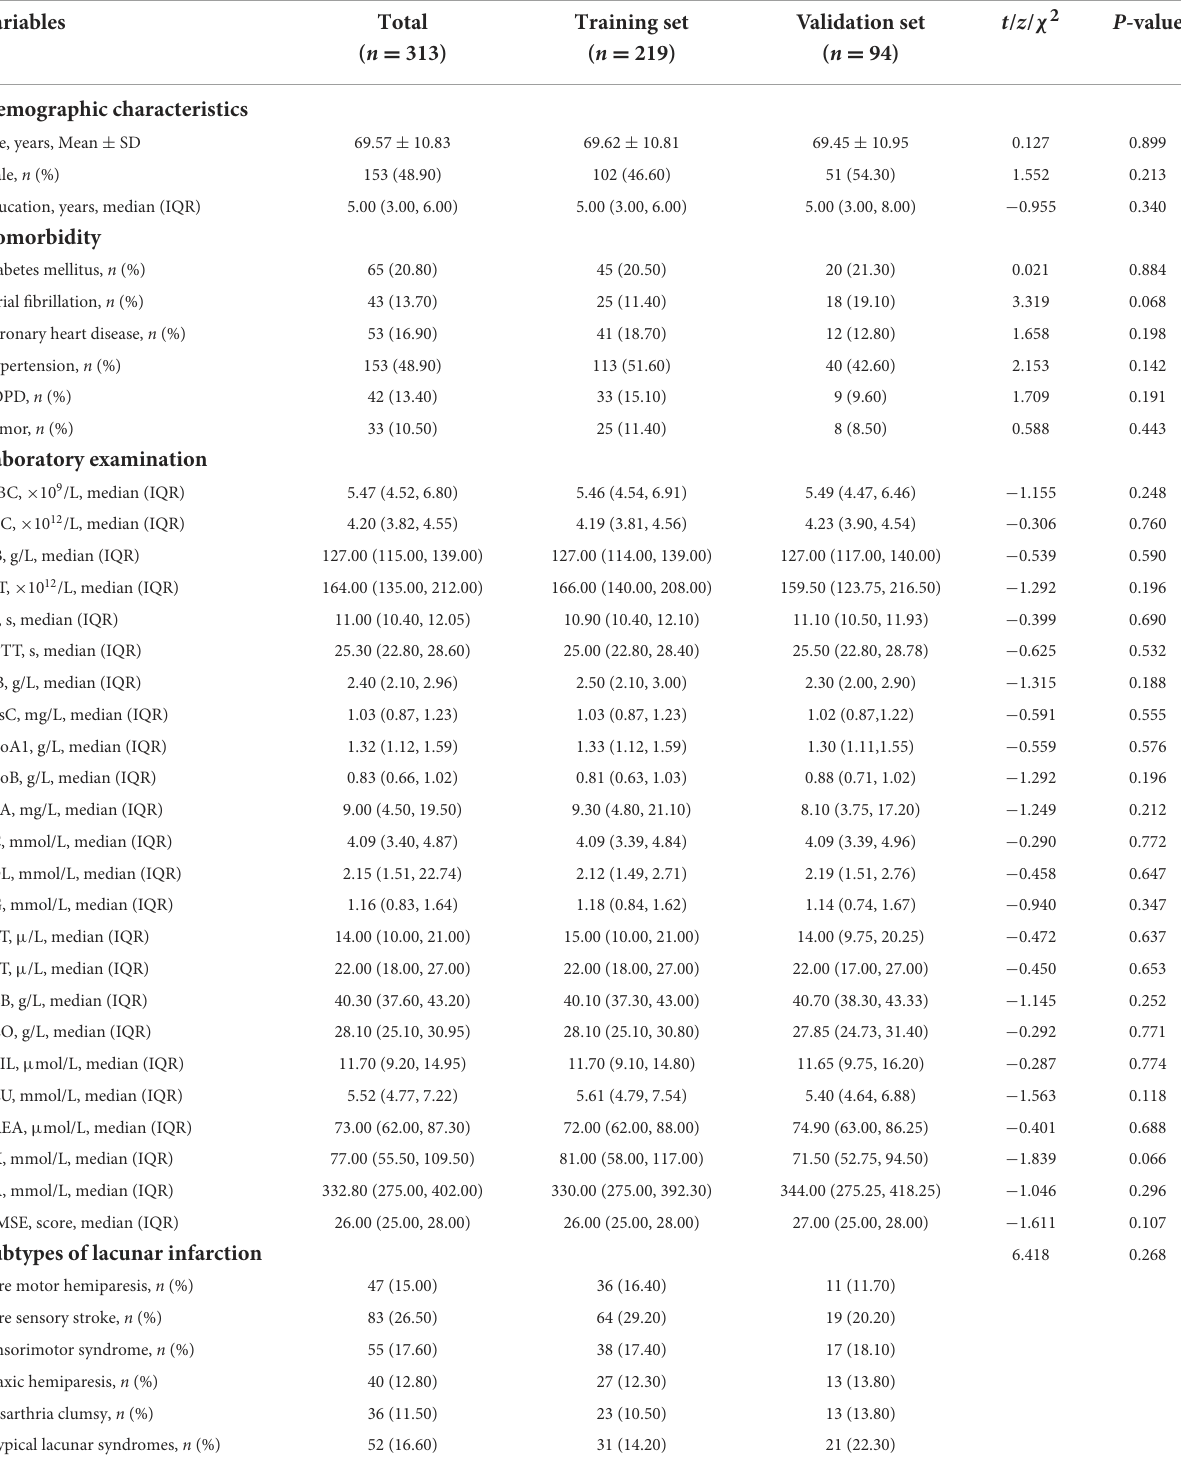
TABLE 1 Baseline and clinical characteristics of lacunar infarction patients in the training set and validation set. Variables Total